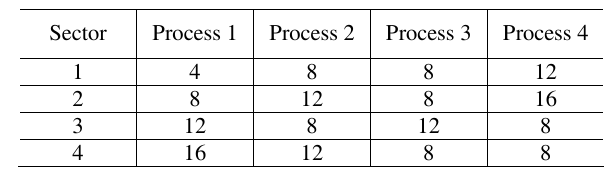
Table 1. Input data